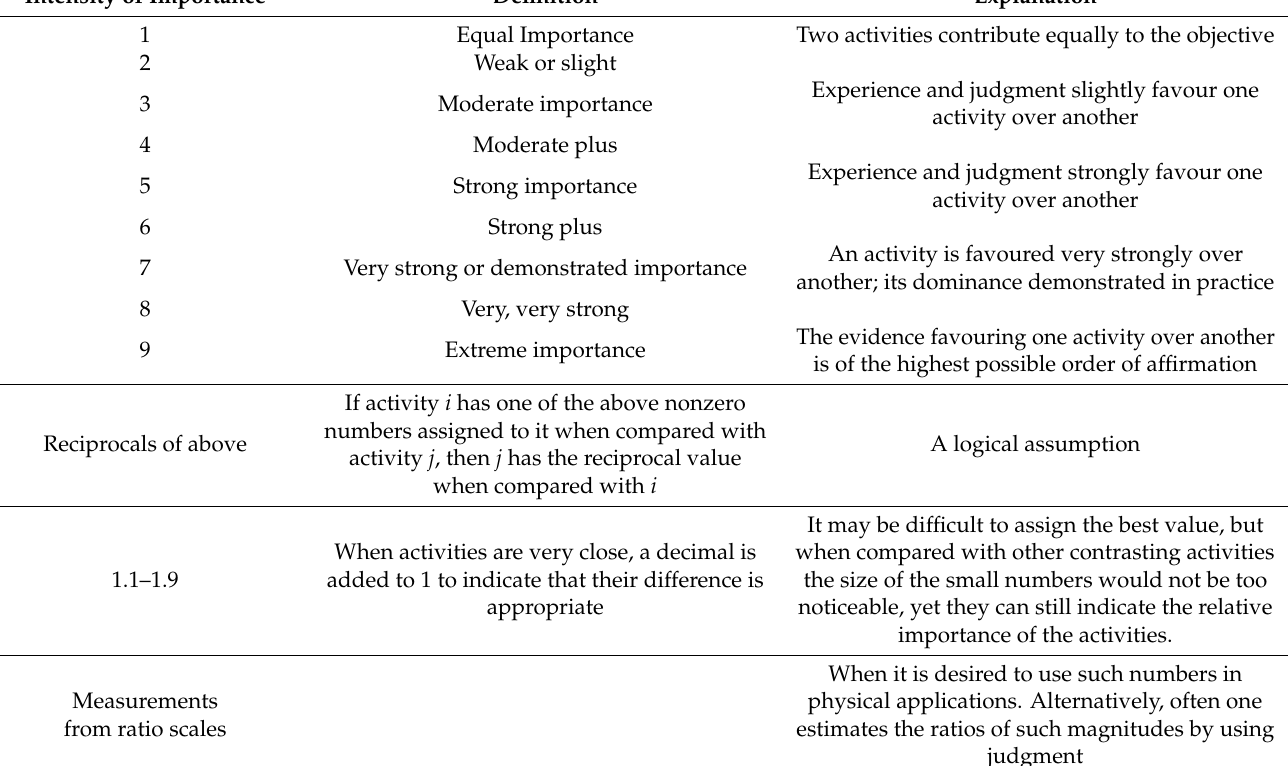
Table 2. The fundamental scale of absolute numbers. Source: